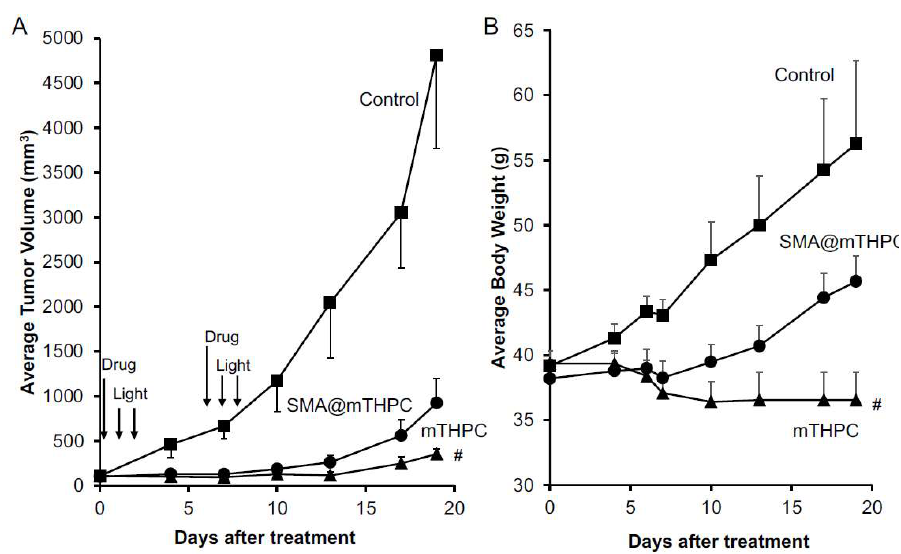
Figure 8. In vivo PDT effect of SMA@mTHPC in S180 solid tumor. A xenon light source was used (MAX-303; Asahi Spectra). Indicated concentrations of SMA@mTHPC were injected i.v. when tumor diameters reached 8–10 mm. After 24 and 48 h, light irradiation (90 mW/cm 2 , 5 min, 27 J/cm 2 ) was carried out. Tumor volume ( A ) and body weight ( B ) were measured every 2 or 3 days. Arrows indicate the application of SMA@mTHPC or mTHPC, and light irradiation. Data are means ± SD; n = 4–8. # one mouse died during the treatment using mTHPC. See text for details.